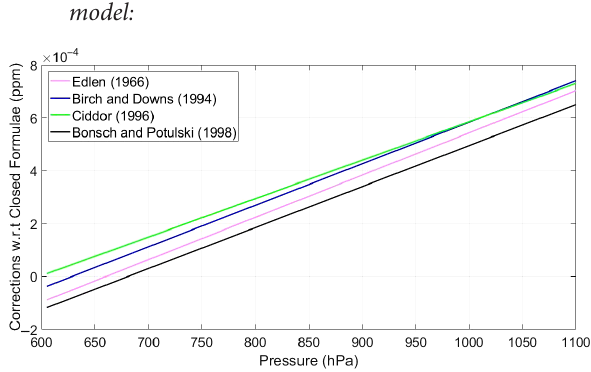
Figure 12. Comparison of EDM corrections w.r.t Closed Formulae model